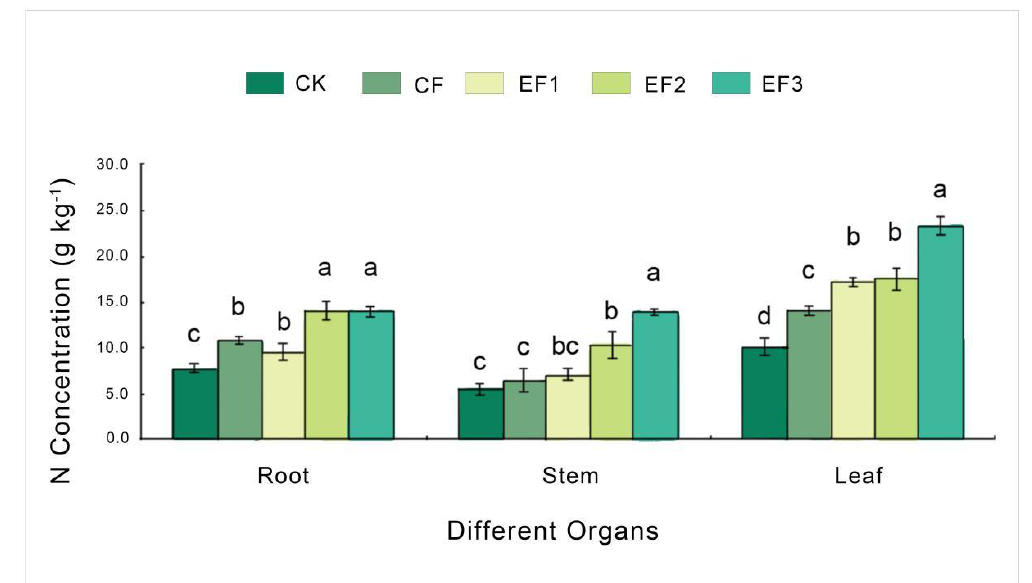
Figure 4. Organ N-concentration of Chinese fir at different fertilization levels. (Different letters in the same histogram of organs indicate significant difference at 0.05 level).